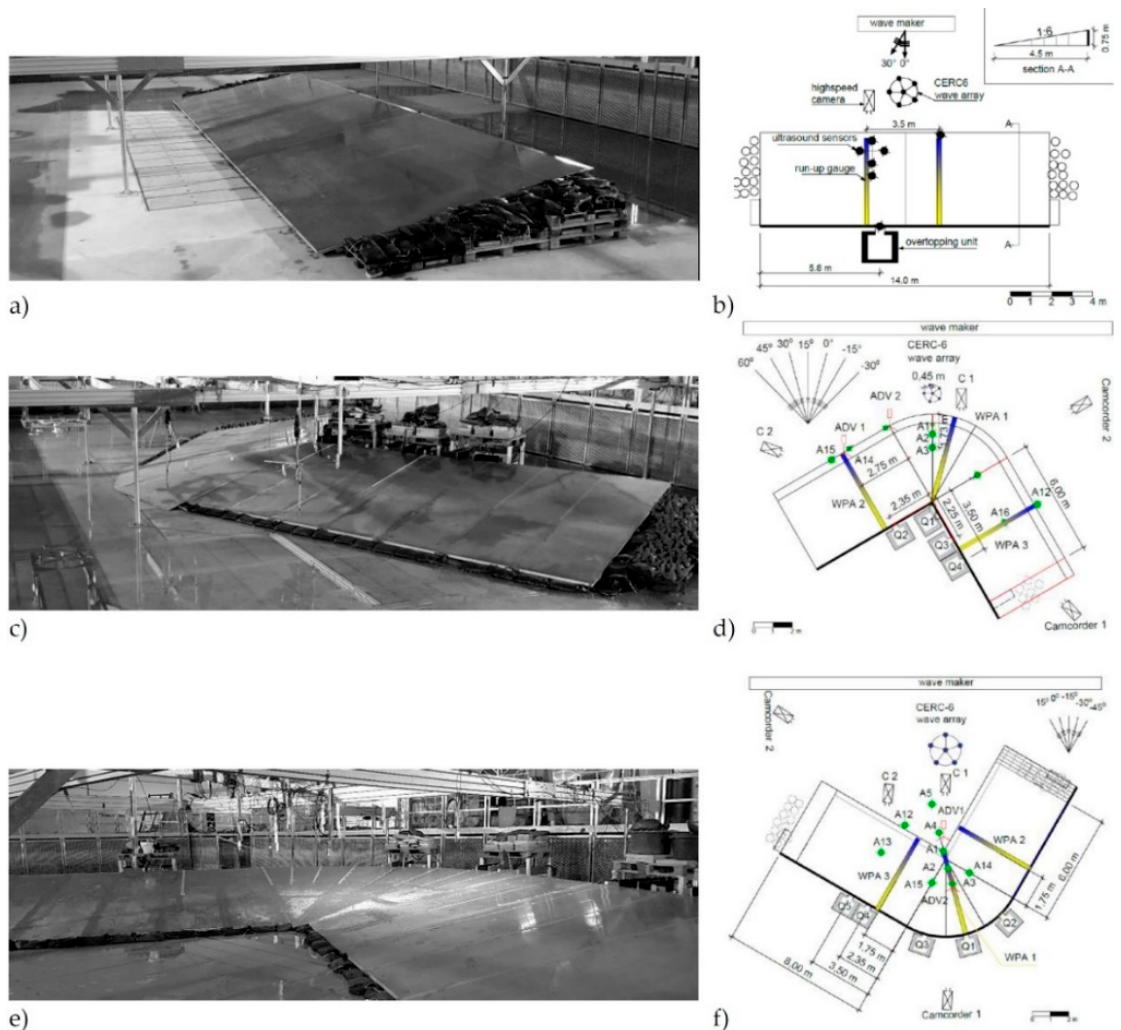
Figure 3. Physical model set-up of the impermeable 1:6 sloped dike model in the wave basin with straight front ( a , b ), convex ( c , d ) and concave curvature ( e , f ). Sensor acronyms: Overtopping unit: 𝑄𝑖 ; velecity probe: 𝐴𝐷𝑉𝑖 ; run-up gauge: 𝑊𝑃𝐴𝑖 ; wave gauge: 𝐴𝑖 ; camera: 𝐶𝑖 , and 𝑖 the sensor number.